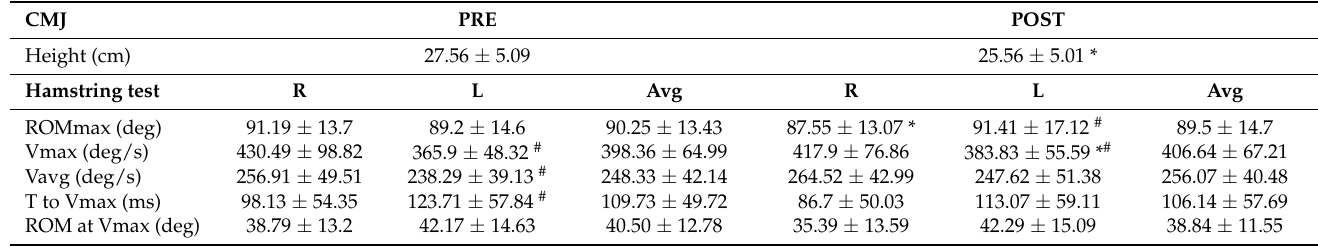
Table 2. Results of the countermovement jump and hamstring